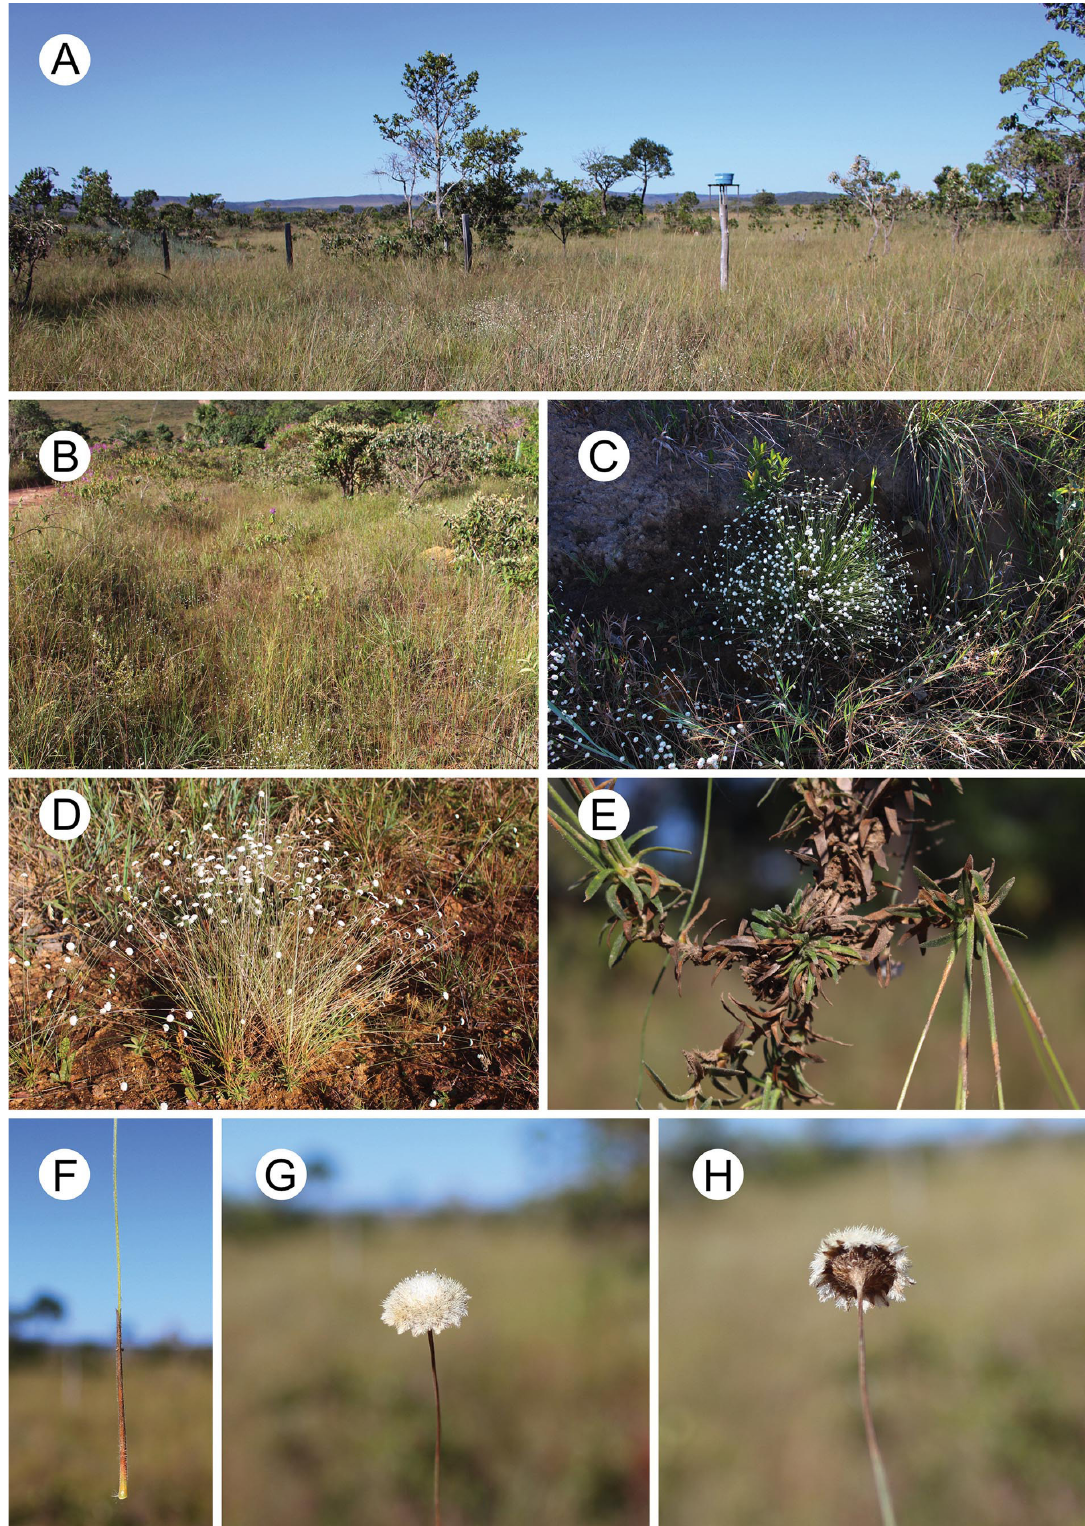
Fig. 3. Actinocephalus brevifolius Trovó & Echtern. sp. nov. A . Habitat. B . Habitat detail. C . Habit. D . Habit detail. E . Rosette and paraclade detail. F . Spathe detail. G . Capitulum detail, view from above. H . Capitulum detail, view from